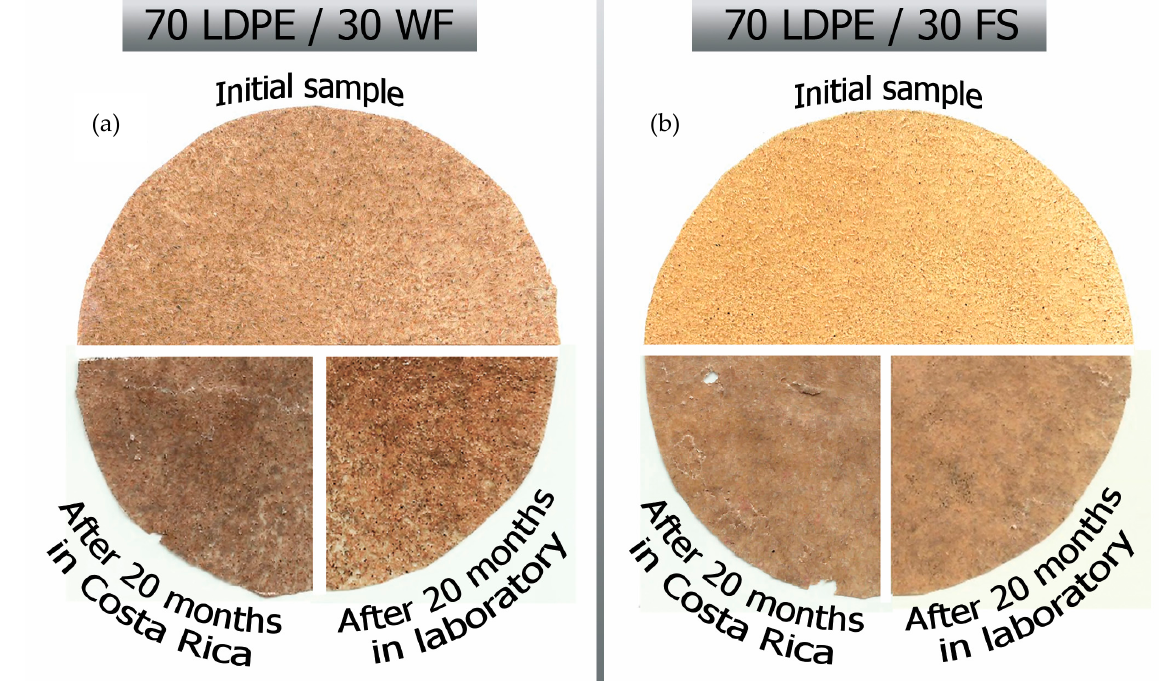
Figure 1. Scanned pictures of biocomposites before and after biodegradation test in the laboratory and in Costa Rica for WF ( a ) and FS ( b ).